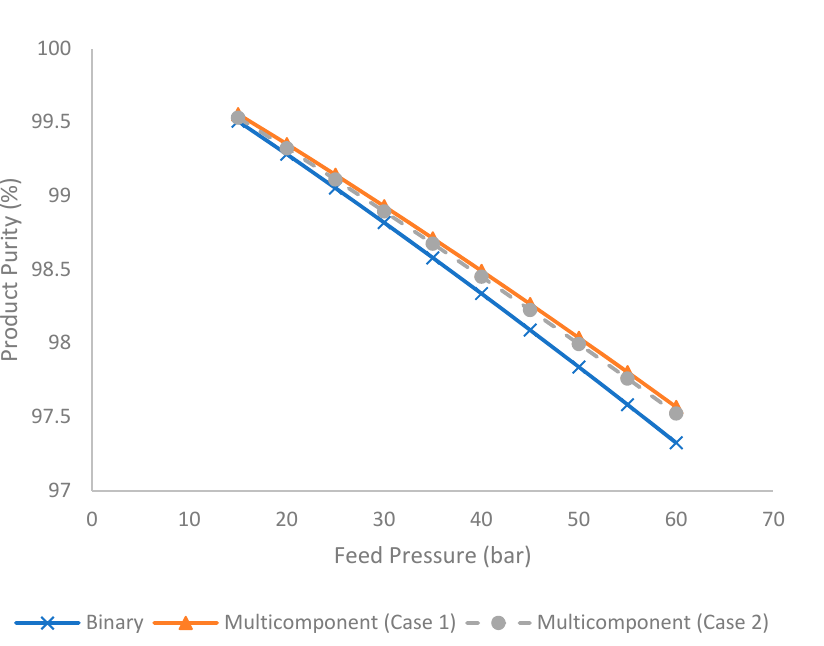
Figure 7. Evolution of product purity (%) under different feed pressure for binary and multicompo- nent systems.